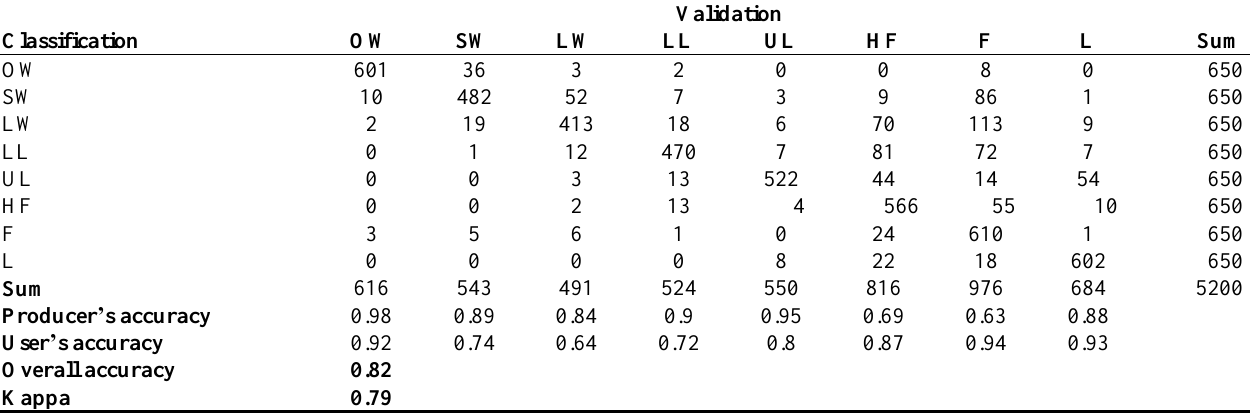
Table 5. Confusion matrix for fine-scale classification of the 10 images (Step 8), considering the original classes of the validation objects.